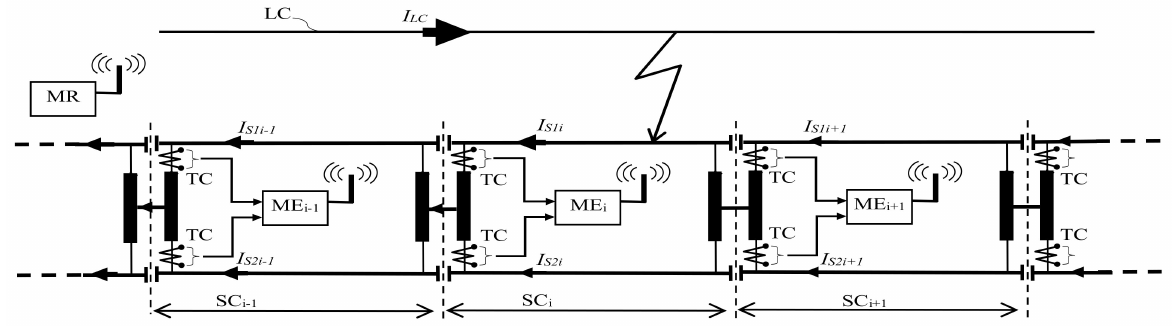
Figure 4. Functional block diagram of the fault location